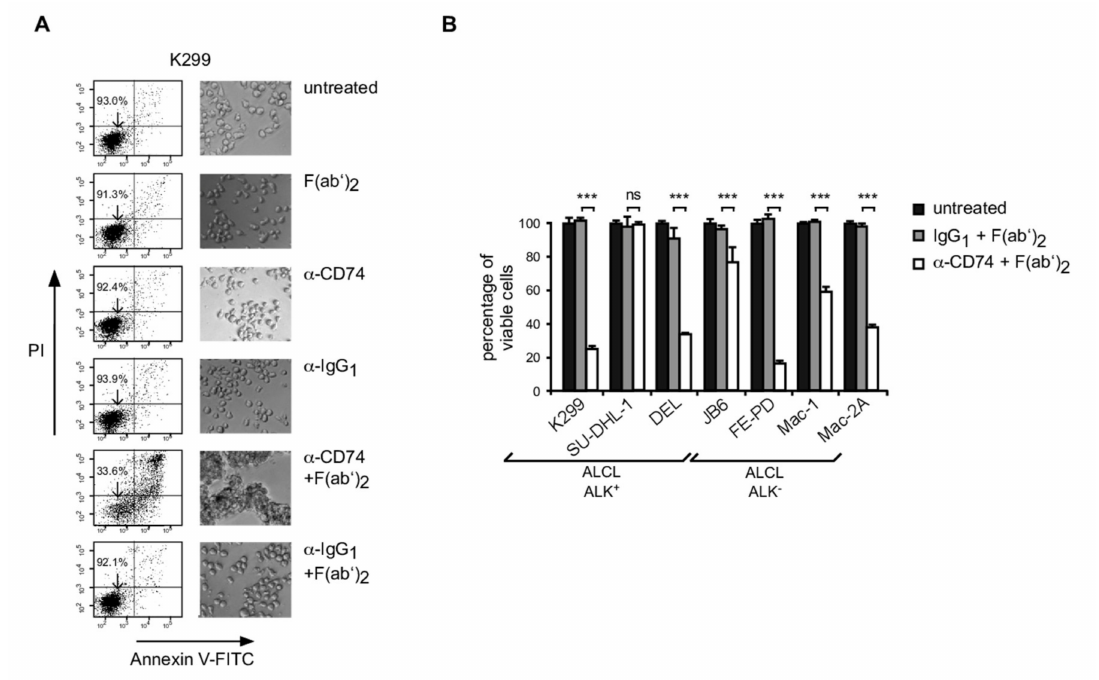
Figure 2. Induction of apoptosis of ALCL cell lines following CD74 ligation. ( A ) K299 cells were left untreated, or treated for 48 h with 20 µ g F(ab (cid:48) ) 2 -fragments (F(ab (cid:48) ) 2 ), 5 µ g anti-CD74 ( α -CD74) or the respective IgG 1 isotype control ( α -IgG 1 ), or anti-CD74 or anti-IgG 1 in combination with F(ab (cid:48) ) 2 -fragments, as indicated. Left, flow cytometry analyses of the respectively treated cells following Annexin V-FITC and PI-staining. The percentage of viable, Annexin V-FITC/propidium iodide (PI) double-negative cells is indicated. Right, transmitted-light microscopy of the cells. Note that strong clustering of cells is observed following treatment with anti-CD74 in combination with F(ab (cid:48) ) 2 . One of three independent experiments is shown. ( B ) Various ALK + and ALK − cell lines were left untreated (black columns), or were treated for 72 h with anti-CD74 in combination with F(ab (cid:48) ) 2 (open columns), or, as control, anti-IgG 1 in combination with F(ab (cid:48) ) 2 (grey columns) as described in (A). Note that SU-DHL-1 cells, which lack CD74 expression, do not respond to CD74 ligation. One of four independent experiments is shown. Error bars denote SDs. ***, p < 0.001. ns, not